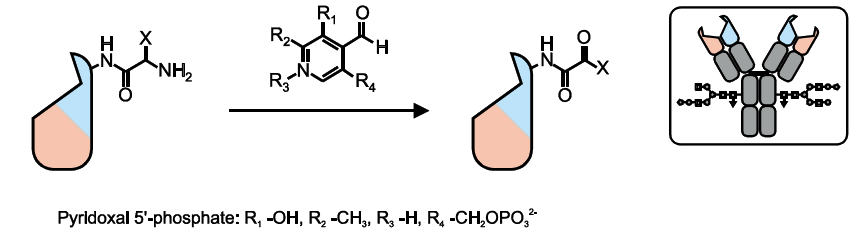
Figure 5. Selective oxidation of the α-amino group of the N-terminal amino acid (X) of heavy and light chain using pyridoxal 5'-phosphate or